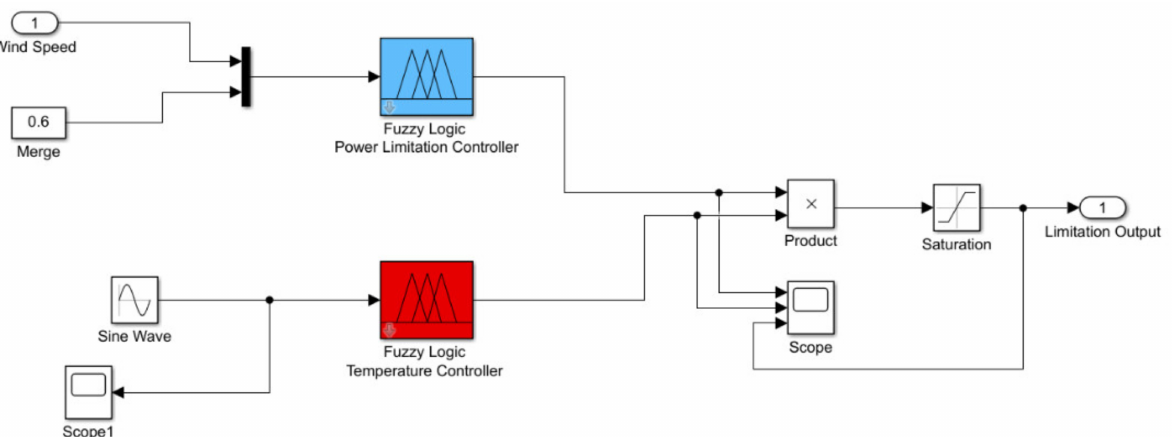
Figure 6. Fuzzy logic implementation in the Simulink control model.